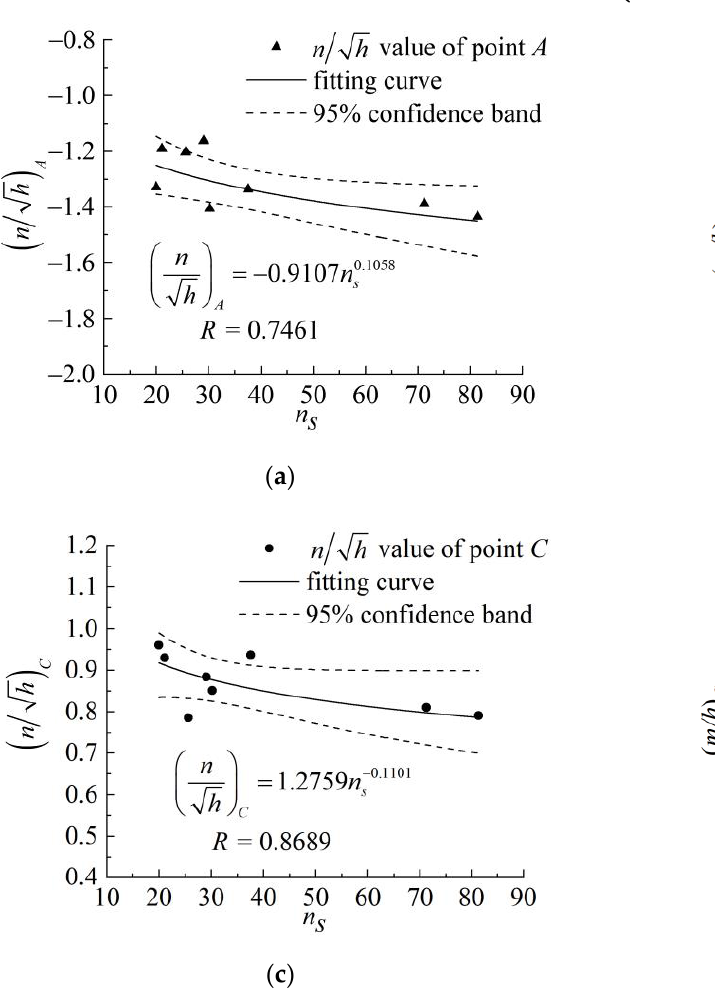
√ (cid:16) (cid:17) − 𝑛 − n s ; n / h 𝑠 ; ( b ) 𝐴 A